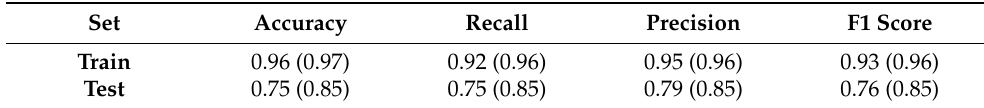
Table 5. Average performance measures of the discriminant